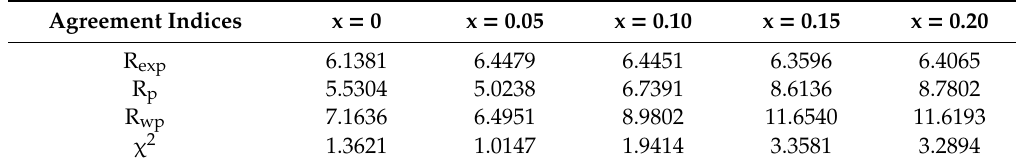
Table 3. Agreement indices from Rietveld refinement for Bi 1 − x Eu x FeO 3 calcined powders.